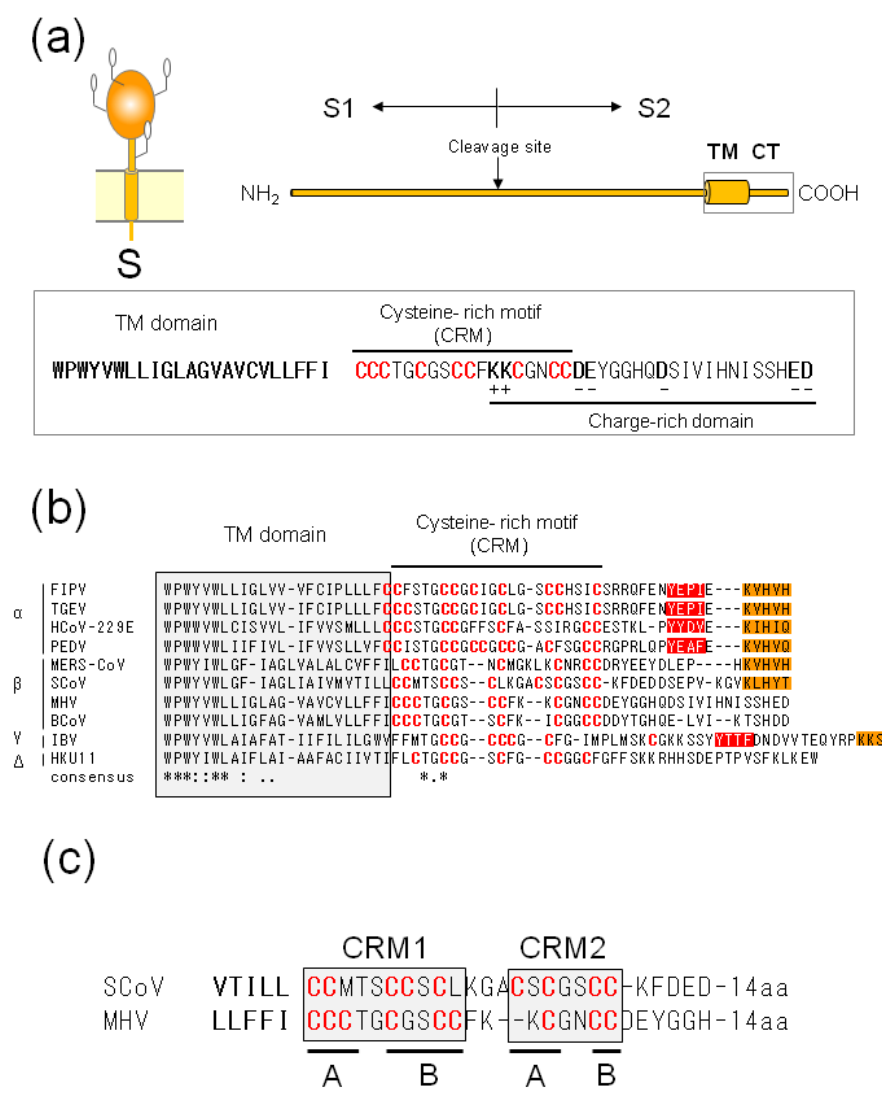
Figure 4. ( a ) Schematic diagram of CoV-S proteins and CT domain amino acid sequences. The CoV S2 domain can be further divided into three subdomains; a large ectodomain, a single TM domain, and a CT domain (top). The deduced CT domain sequence of MHV-S (A59) protein comprises two subdomains: a cysteine-rich motif (CRM) and charge-rich domains, which partially overlap (bottom); ( b ) C -terminal ends of 10 CoV-S proteins. Amino acid sequence alignment was performed by CLUSTALW. Shaded box indicates the deduced TM domain. Cysteine residues in CRM are shown in red. Orange and red boxes indicate potential ER retrieval signals (KxHxx- or KKxx-motif) and tyrosine-dependent localization signals/internalization signals (YxxФ motif, where Ф can be F, I, L, M or V), respectively. ( c ) Comparison of the CRM domains of SCoV- and MHV-S. The CRM can be further divided into four